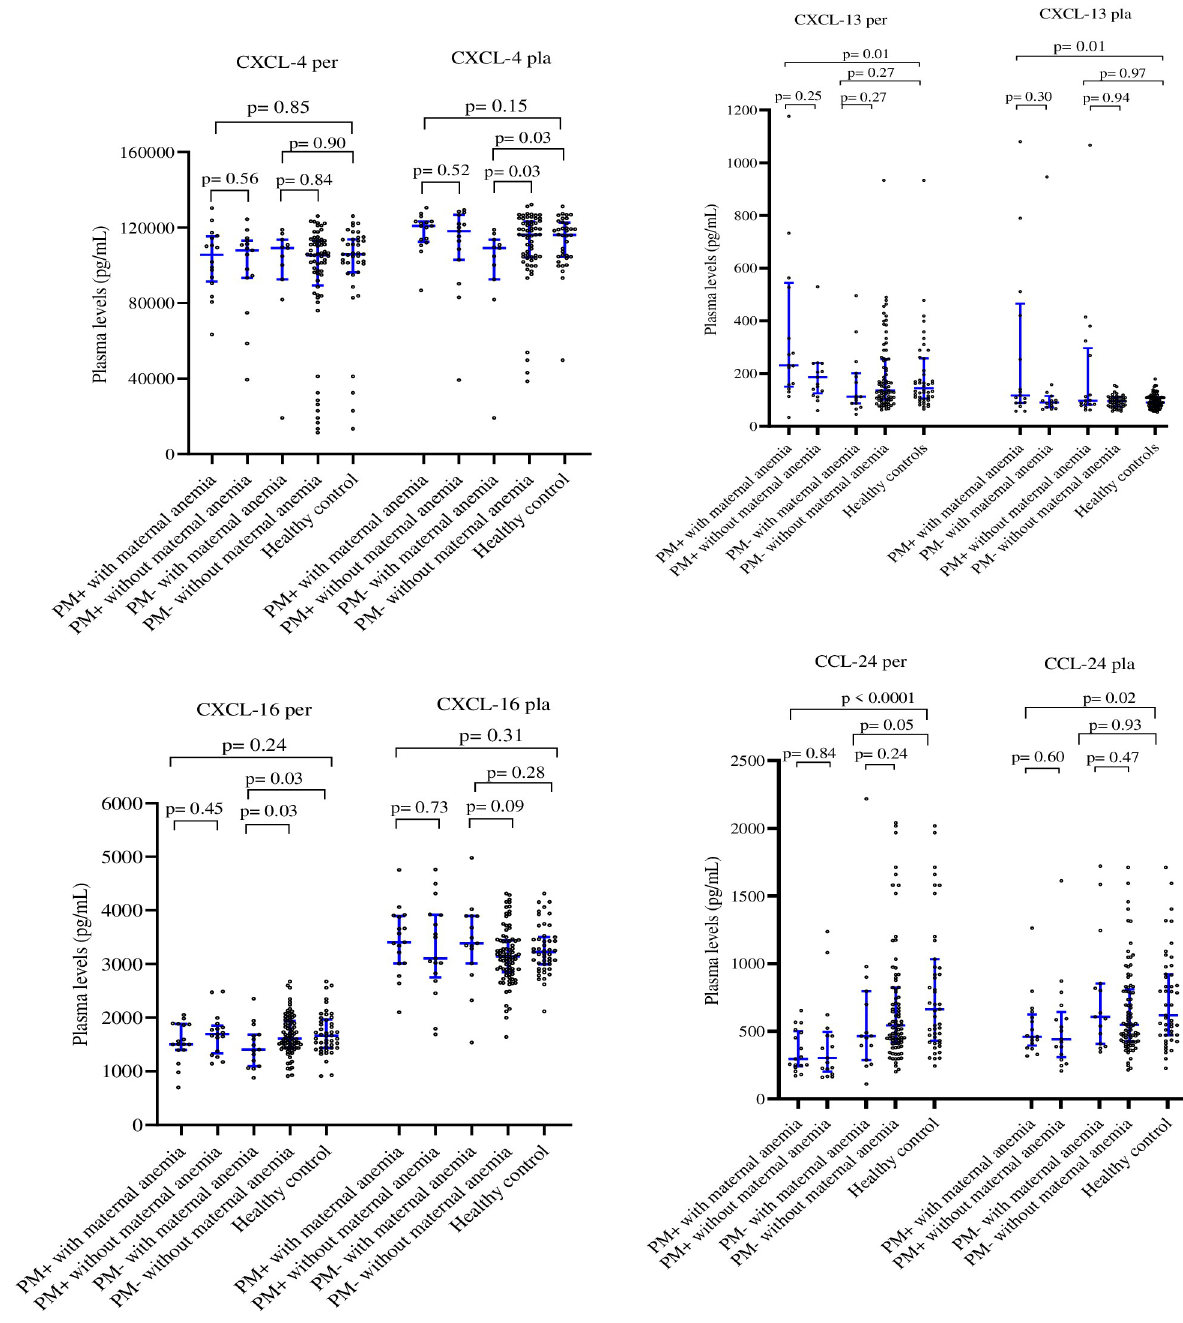
Fig 2. Plasma levels of CXCL-4, CXCL-13, CXCL-16, and CCL-24 chemokines in anemia positive-women and anemia negative-women at delivery. The levels of different chemokines in peripheral (Per), placental (Pla) were compared between anemic and non-anemic women at delivery, using Mann Whitney test. PM-: Placental malaria negative-women; PM+: Placental malaria positive women; healthy controls: placental malaria negative-women with negative peripheral blood RT-LAMP test.